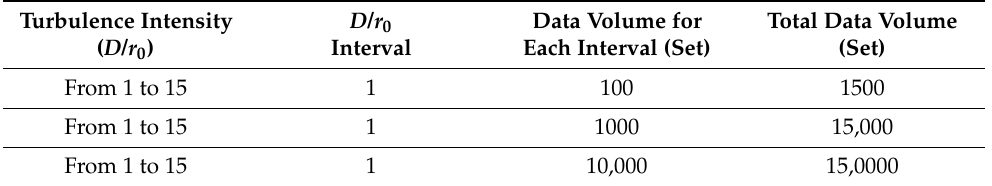
Table 1. Generated training data